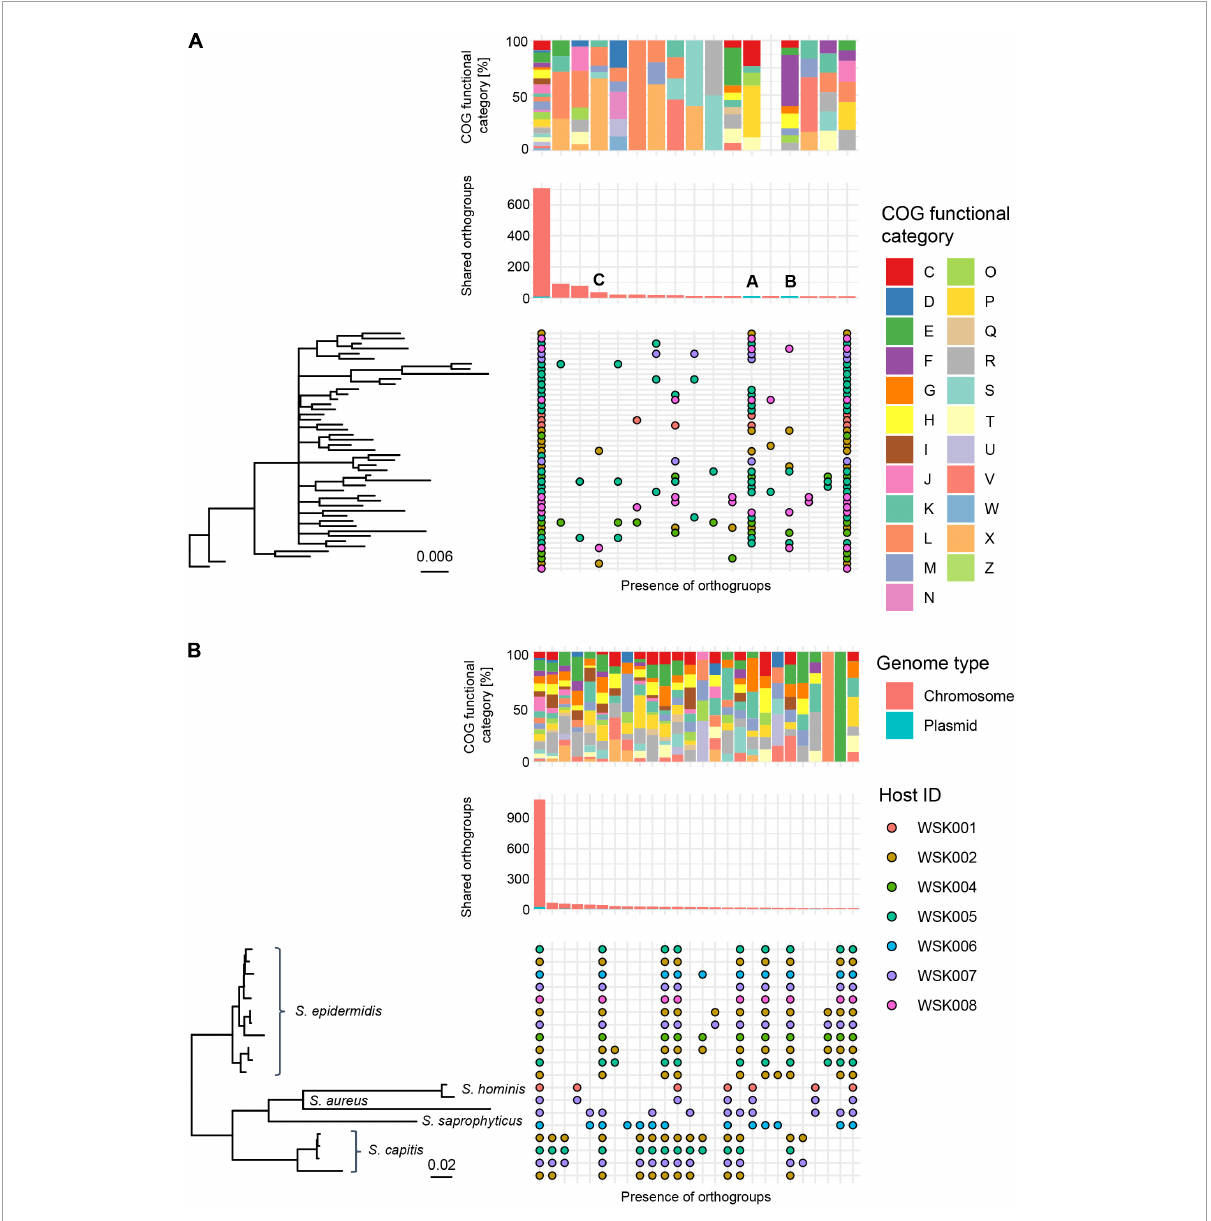
FIGURE4 Pangenome analysis of HQ SAGs in Moraxella osloensis and Staphylococcus spp. (A,B) Profiles of orthogroups (OGs) in (A) 47 Moraxella osloensis and (B) 19 Staphylococcus spp. ( S. epidermidis , S. aureus , S. capitis , S. hominis , and S. saprophyticus ). The upper box shows the composition of the COG category in each gene occurrence pattern. The middle bar plot shows the number of OGs with plasmid prediction. The bottom chart shows the presence/absence of OGs that constitute the pangenome of analyzed HQ SAGs sorted with the phylogenetic tree based on the OGs. Occurrence patterns are shown in which more than 10 OGs were present. No occurrence patterns are shown where OGs are missing in only one HQ SAG of all strains.